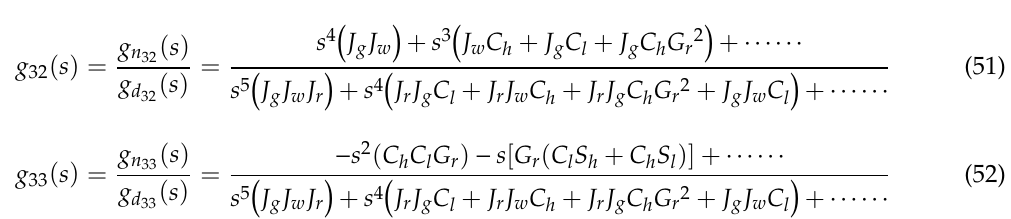
Table 2. Wind turbine parameters.